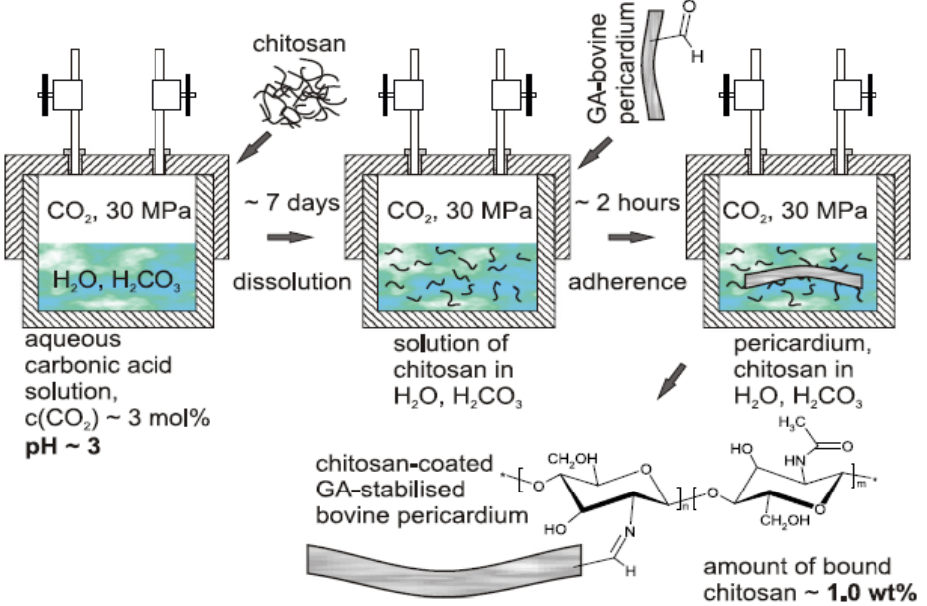
Figure 10. Scheme of bovine pericardium (BP) modification in solutions of CH/H 2 CO 3 . Reprinted with permission from ref. [166]. Copyright 2014, Elsevier.